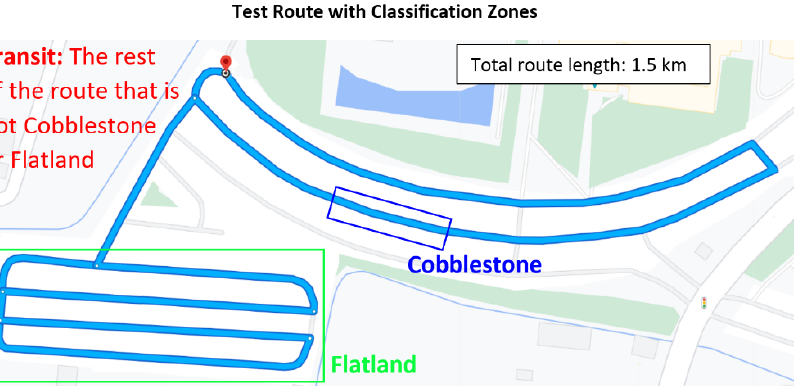
Figure 4. Test route with defined zones.